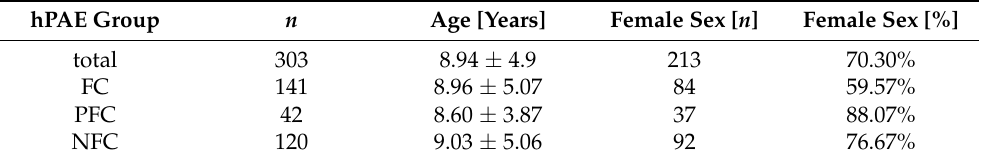
Table 1. Demographic data of patients involved in the study.